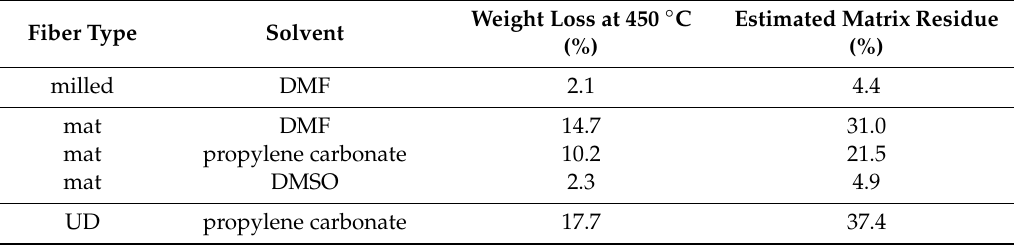
Table 2. Solvolysis tests on M22 composites and results of TGA on the recovered fibers, namely weight loss at 450 ◦ C and estimated amounts of residual matrix. TGA performed in inert